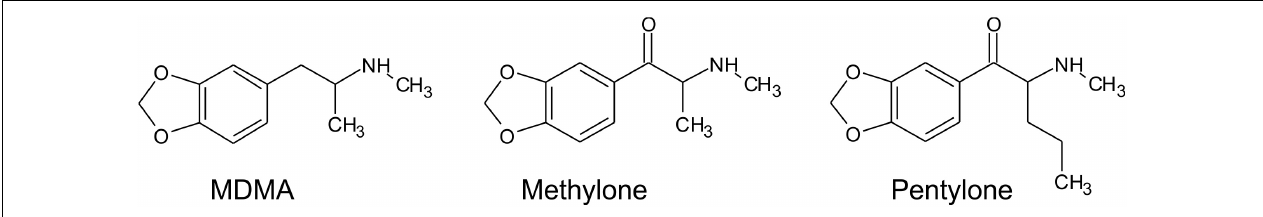
FIGURE 1 | Structural formulae of MDMA, Methylone, and